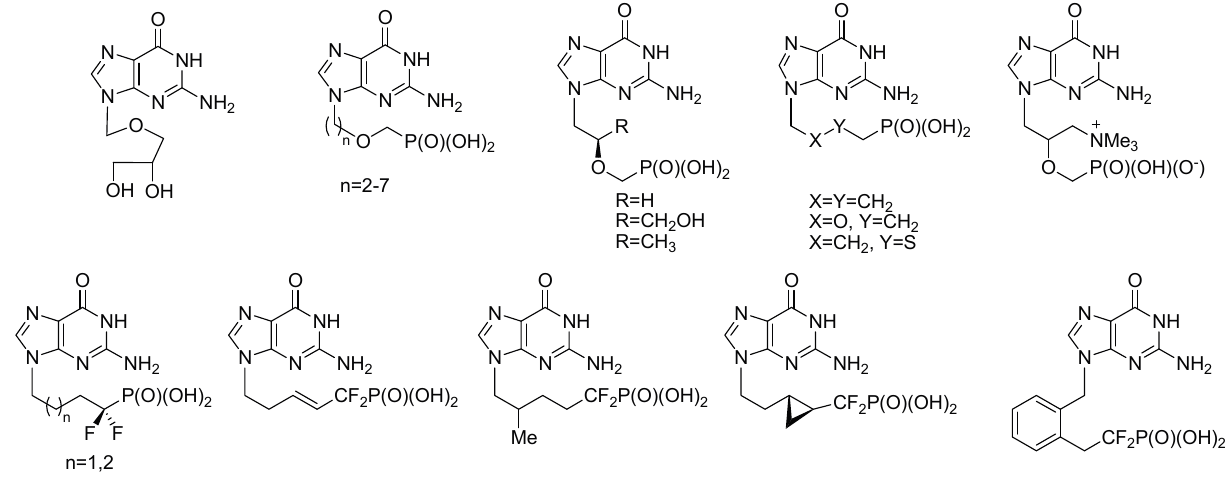
Figure 1. Known biologically-active acyclic analogues of